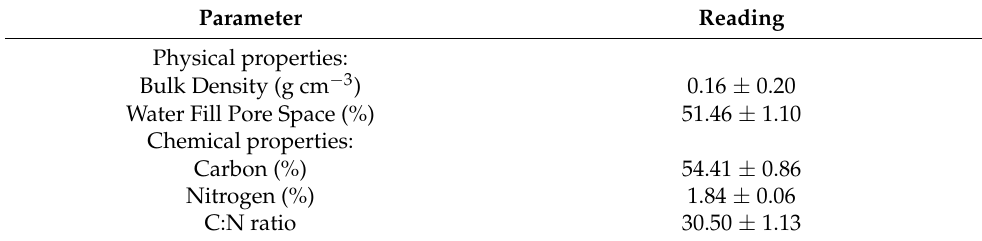
Table 1. Physical and chemical properties of peat soils from the site. Parameter Reading Physical